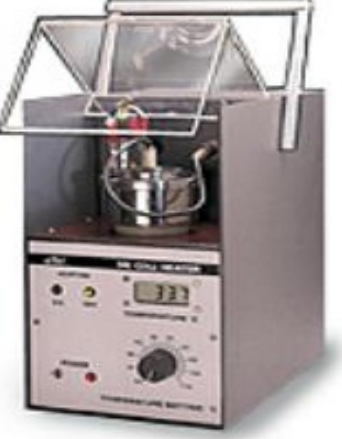
Fig. 2. (Color online) Oil Test Cell Heater.